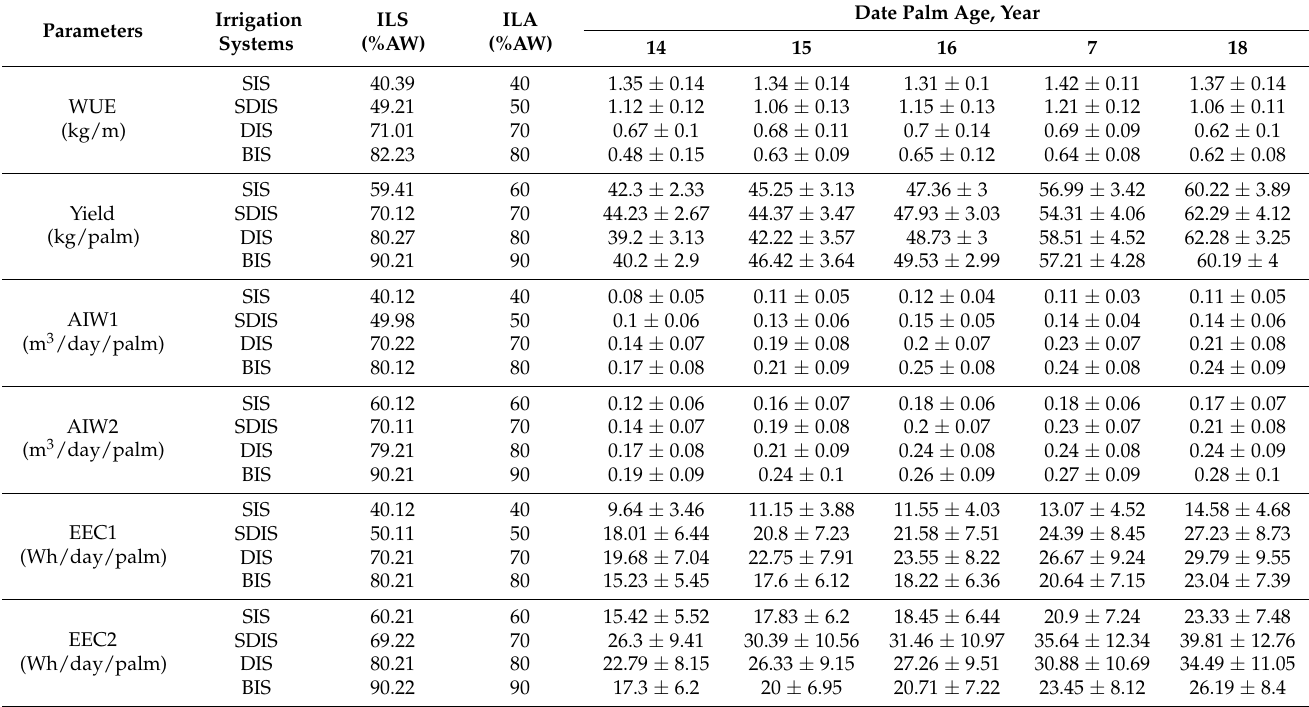
Table 4. The average values ( ± standard deviation) of water use efficiency (WUE), date palm yield, applied irrigation water at optimum WUE (AIW1), applied irrigation water at optimum yield (AIW2), the electrical energy consumed at optimum WUE (EEC1), the electrical energy consumed at optimum yield (EEC2) under micro irrigation systems, and date palm